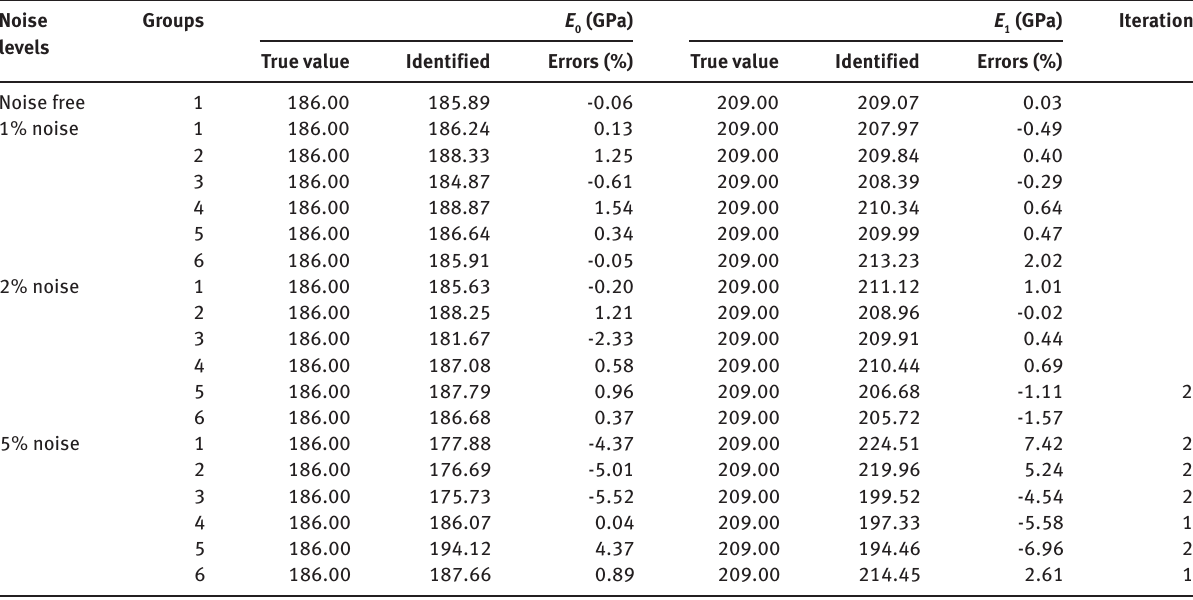
Table 14: Identified parameters of a rectangular FGM plane structure with exponential material variation (case 3: initial value E = 313 GPa). E 1